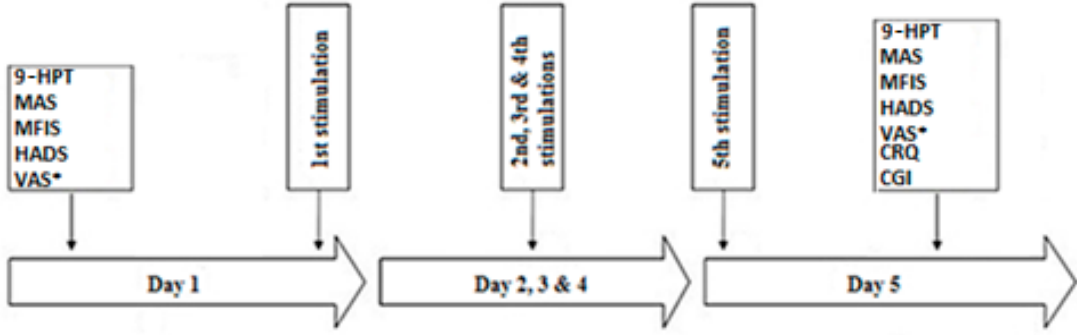
Figure 3. The schematic diagram of the study protocol. 9-HPT: Nine-Hole Peg Test; CGI: Clinical Global Impression; CRQ: Comfort Rating Questionnaire; HADS: Hospital Anxiety and Depression Scale; MAS: Modified Ashworth scale; MFIS: Modified Fatigue Impact Scale; VAS*: Visual Analogue Scale for the pain recorded one week before and after the beginning of each block.